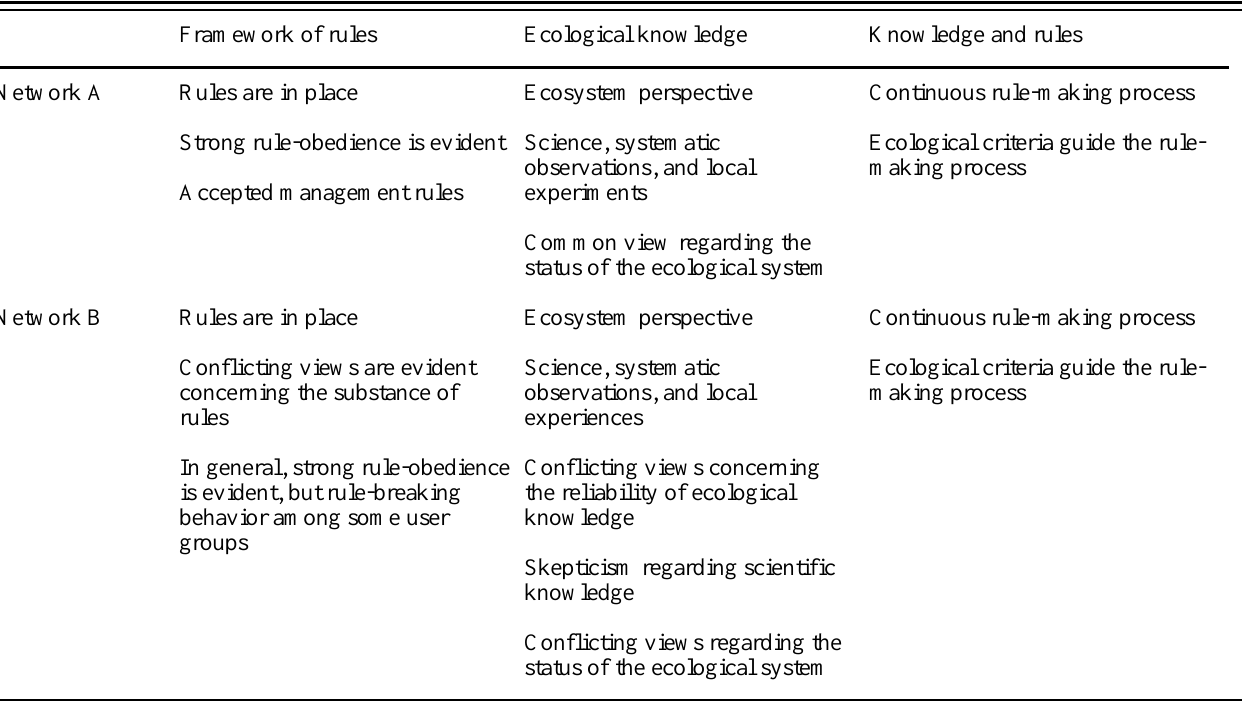
Table 1. Aspects of